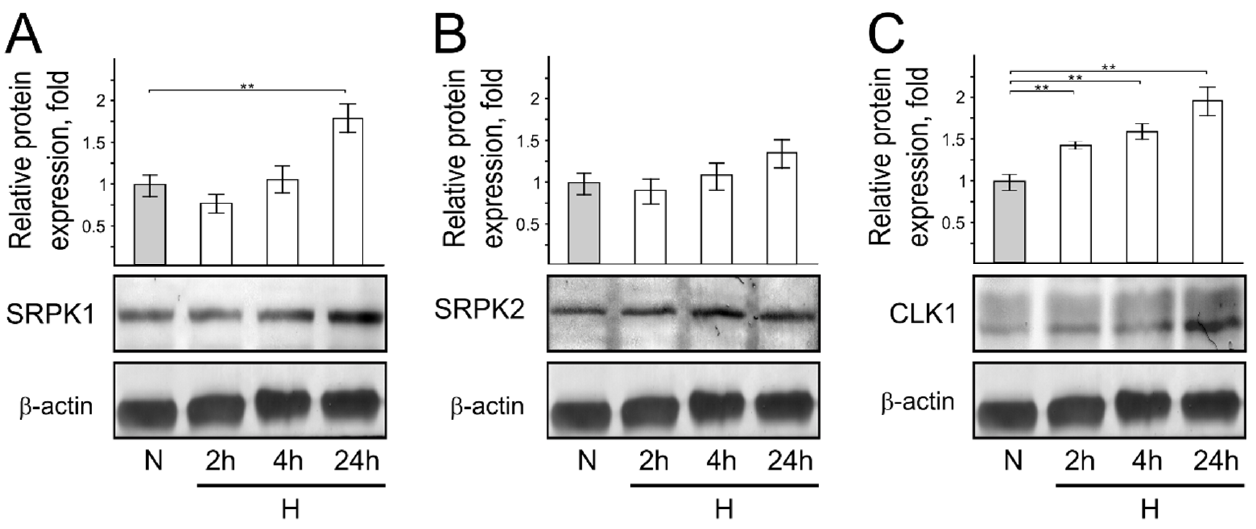
Figure 5. Protein kinase SRPK1, SRPK2, and CLK1 protein expression in normoxic and hypoxic HCT116 cells. Western blot showing SRPK1 ( A ), SRPK2 ( B ), and CLK1 ( C ) protein expression levels in normoxic and hypoxic cells. Bar plot represents the quantification of endogenous protein expression of 3 independent experiments when protein expression in cells grown under normal oxygen conditions is taken as 1. Error bars represent the amount of spread between the extremes of the data, ** p < 0.05. N—cells cultivated under normal conditions; H—cells cultivated under hypoxic conditions for indicated time (2 h, 4 h, and 24